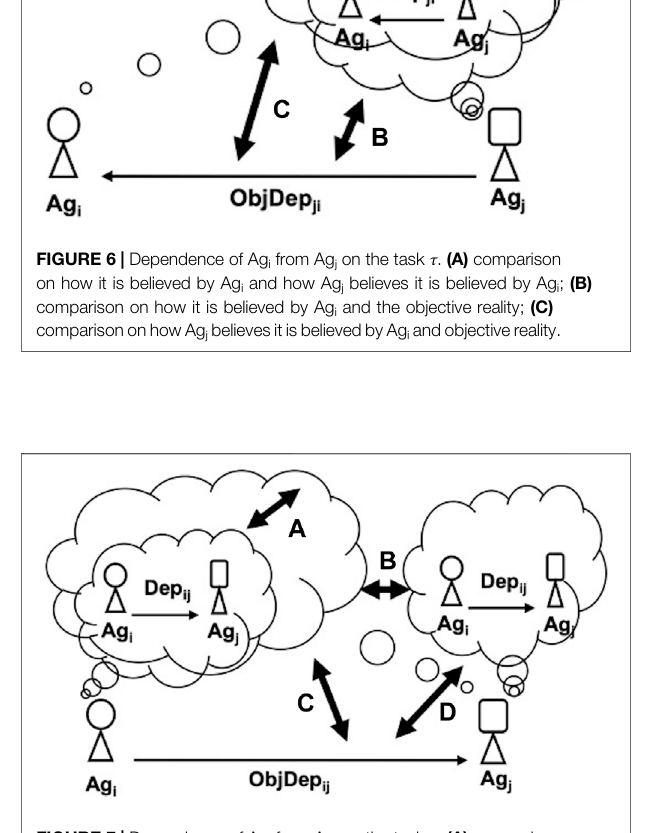
( ObjDep i,j, τ ) (cid:1) ObjDep i,j, τ ) and therefore does reality ( Bel Ag i not correspond to the real Ag j ’ s point of view; or Ag j ’ s point of view coincides with reality ( Bel Ag ObjDep i,j, τ ) , and therefore Ag i ’ s point of view does not view (of Ag i and Ag j ) coincides with reality: Bel Ag ObjDep i,j, τ and at the same time Bel Ag ObjDep i,j, τ .